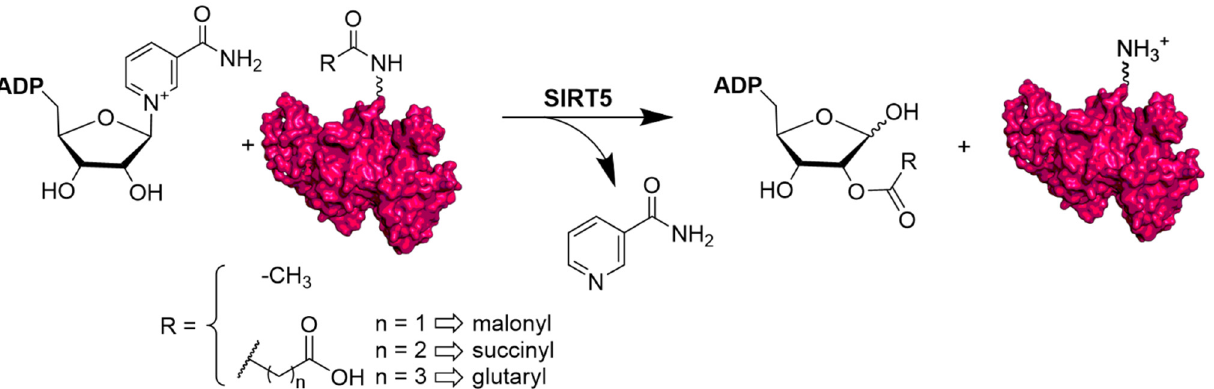
Figure 1. NAD + ‐ dependent deacetylation, demalonylation, desuccinylation, and deglutarylation re ‐ Figure 1. NAD + -dependent deacetylation, demalonylation, desuccinylation, and deglutarylation actions catalyzed by human SIRT5. reactions catalyzed by human